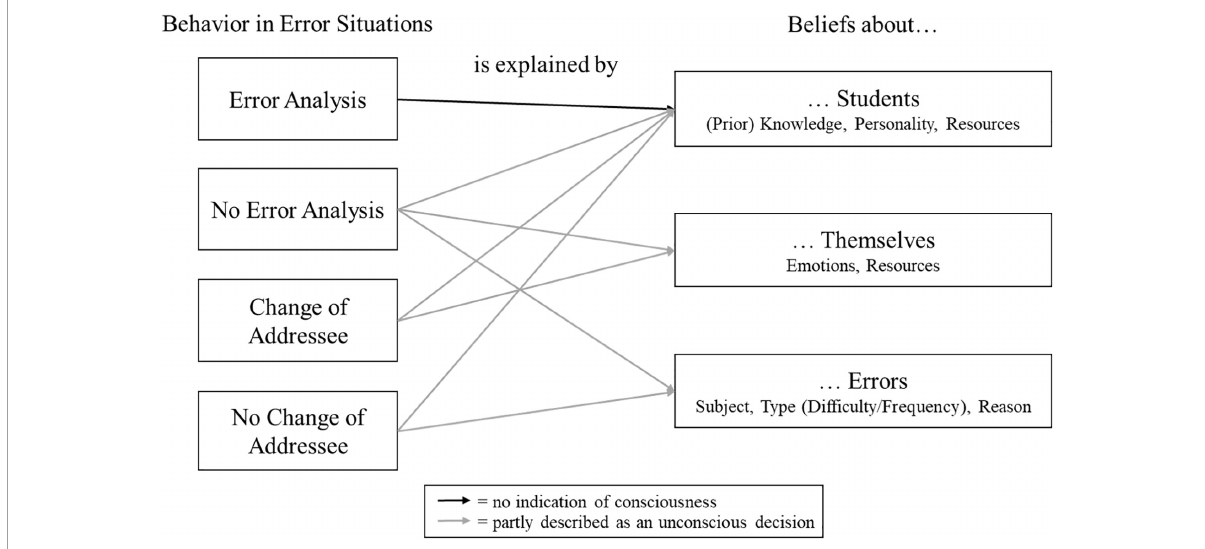
FIGURE1 Explanatory model for behavior in error situations demonstrated in this study ( n = 5).